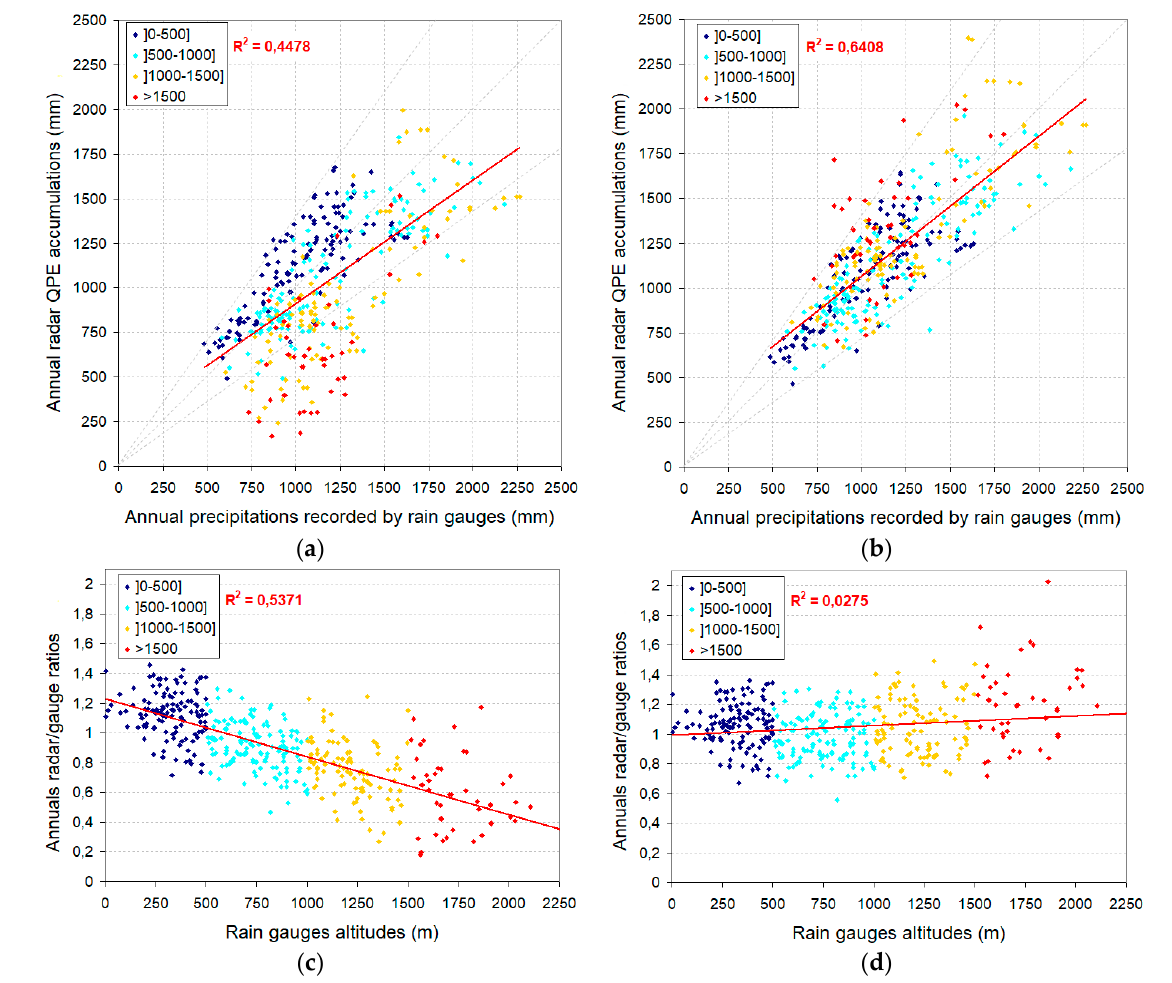
Figure 1. Comparison between annual radar quantitative precipitation sstimation (QPE) and rain gauge measurements, for 430 rain gauges in the French Alps in 2016 (colors function of the rain gauges altitude in m): ( a ) scatter plot of radar QPE vs rain gauge data; ( b ) the same after the linear correction; ( c ) radar QPE bias as a function of rain gauges altitudes, for operational data; and ( d ) the same after the linear correction.